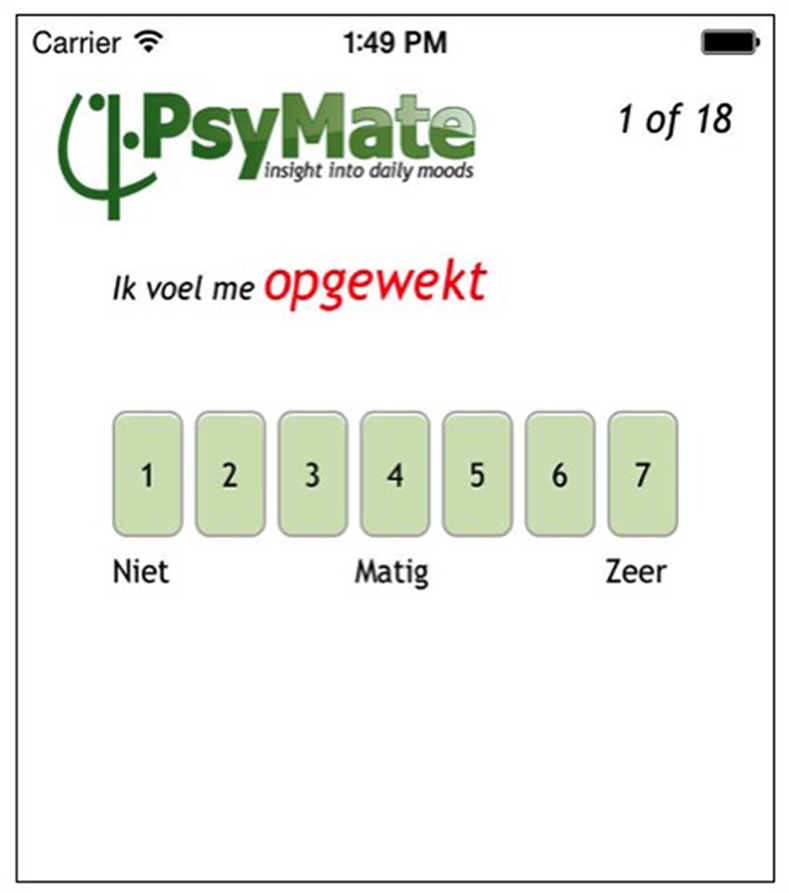
Screenshot of the question “Ik voel me opgewekt”(“I feel cheerful”) on a 7 point Likert scale.A score of 1 indicates “niet” (“not at all”), a score of 4 “matig” (“moderate”) and a score of 7 “Zeer” (“Very much so”).